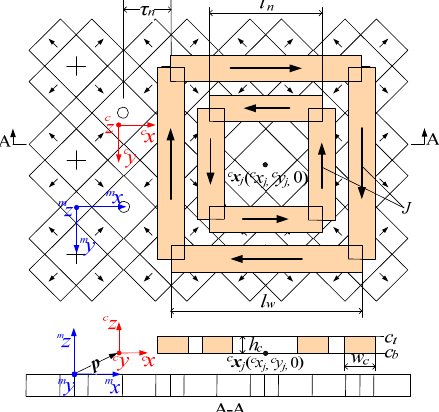
Figure 2. Top views and A-A view of the components of a maglev planar motor: a Halbach array and a concentric structure winding.